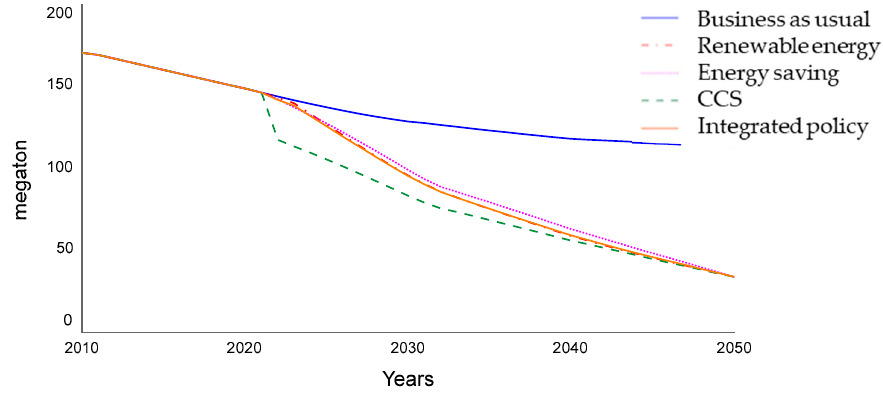
Figure 9. Total CO 2 released per year 2010–2050